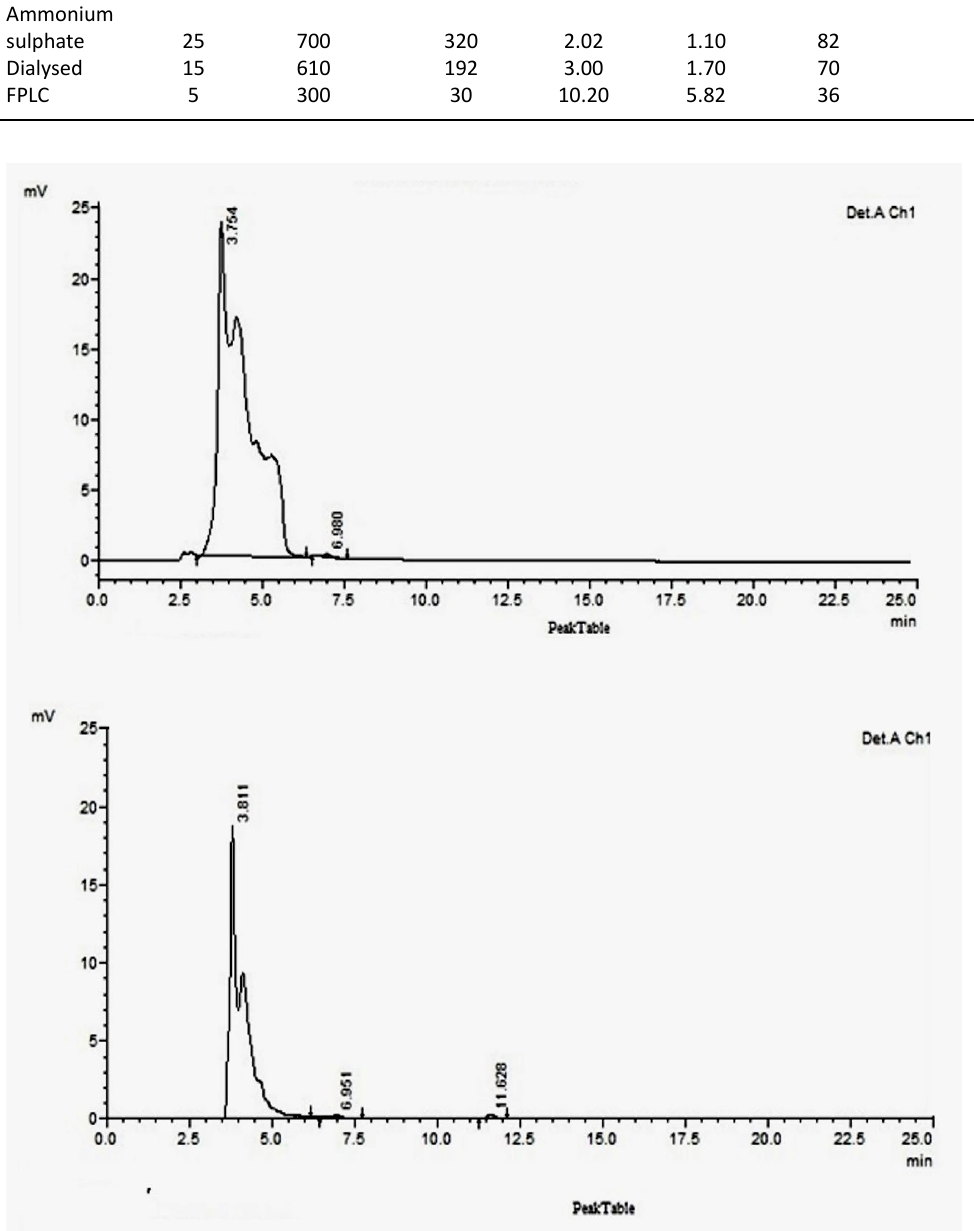
Fig. 7. HPLC chromatograms (A) Congo red-21 parent dye after its degradation by immobilized